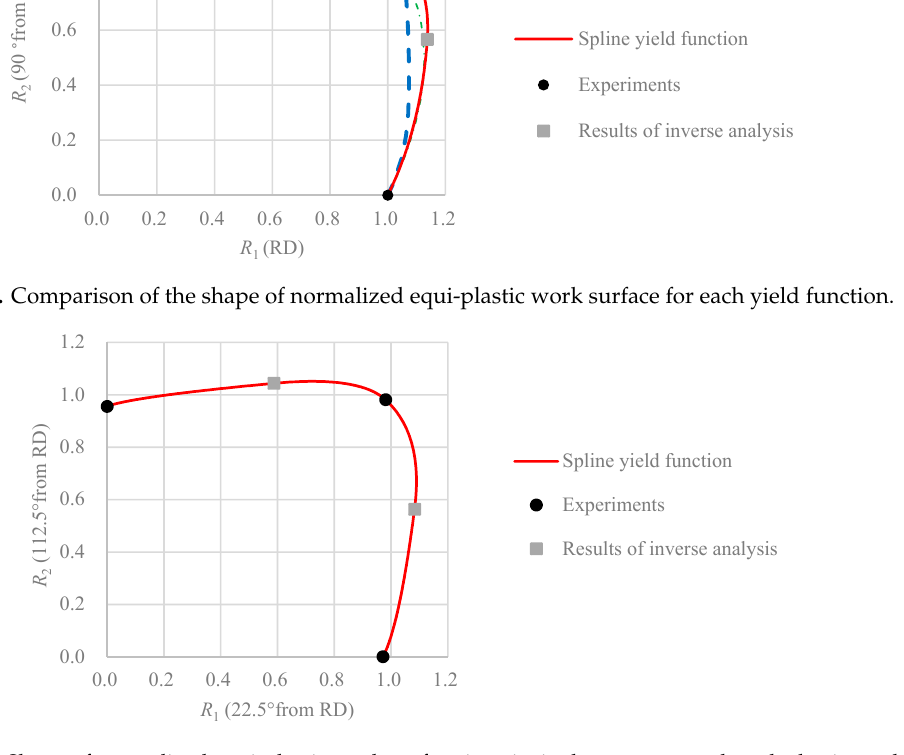
Figure 13. Shape of normalized equi-plastic work surface in principal stress space when the horizontal axis was 22.5° from the RD.